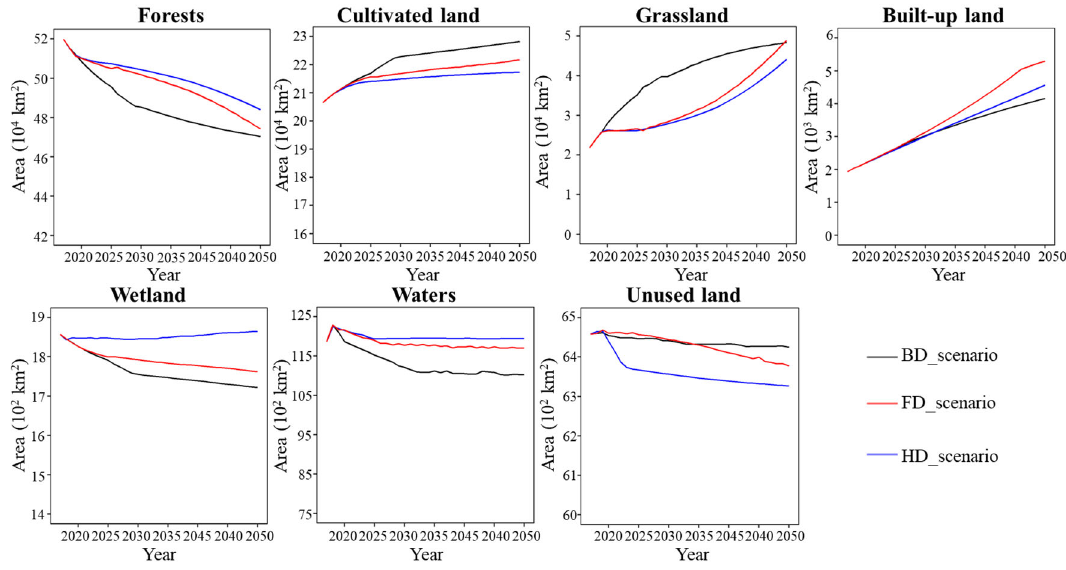
Figure 6. Projection of the land use structures under different scenarios in Myanmar from 2017 to 2050.